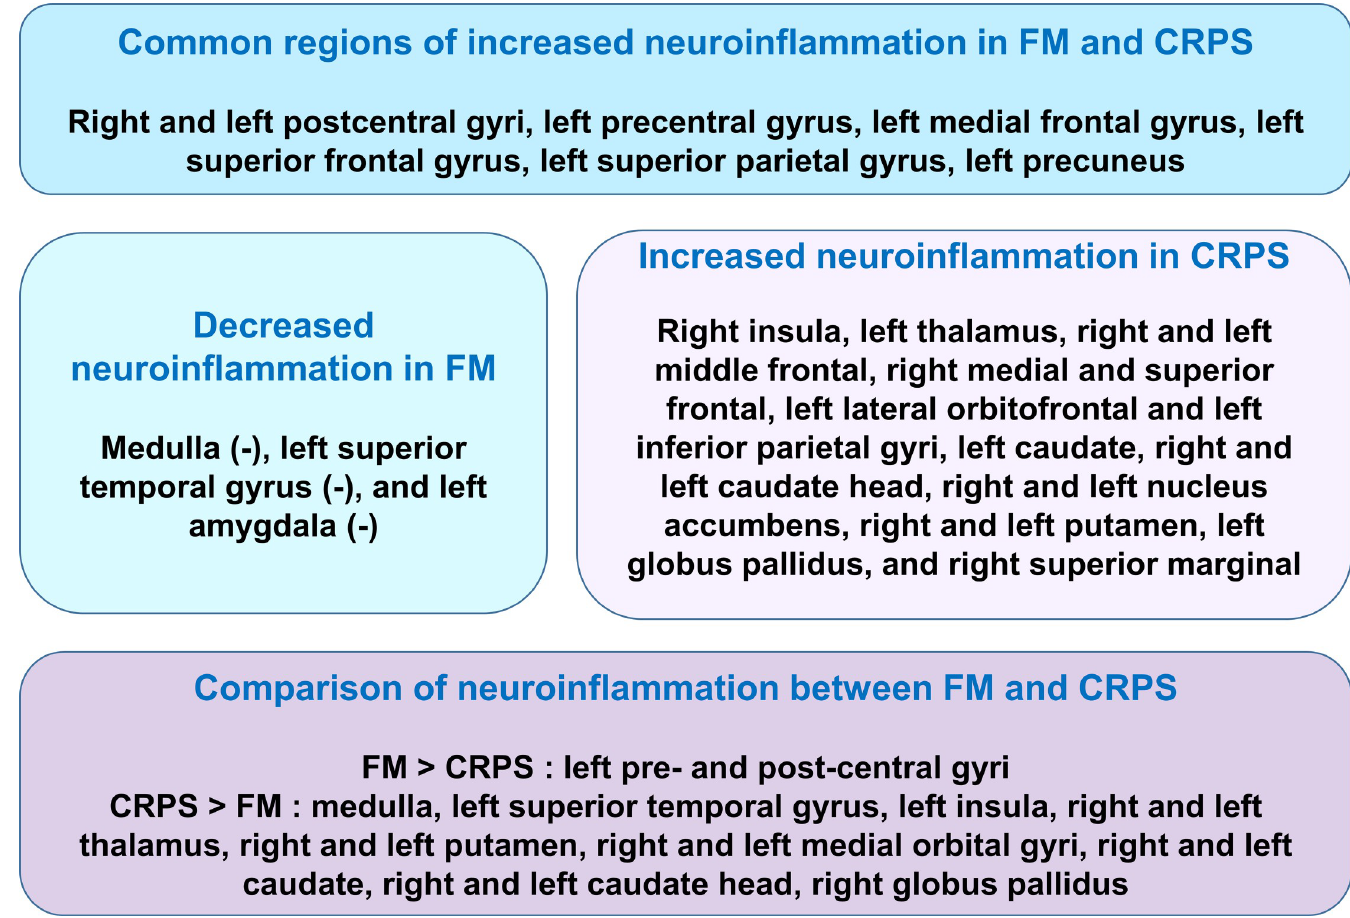
Fig 5. Common and different regions of abnormal neuroinflammation in FM and CRPS patients. FM : fibromyalgia, CRPS : complex regional pain syndrome. (-) : Decreased neuroinflammation.